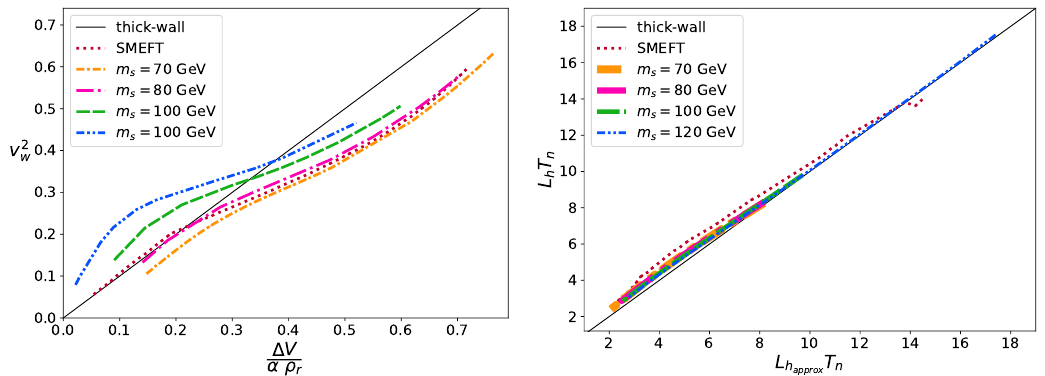
Figure 18 . Left: comparison between the wall velocity calculation using the semiclassical method and the thermal equilibrium formula, eq. (8.1). Right: comparison between our results for the wall thickness in the Higgs direction with the estimated formula eq. (8.7). Both: the solid black line has slope one and is plotted for visual